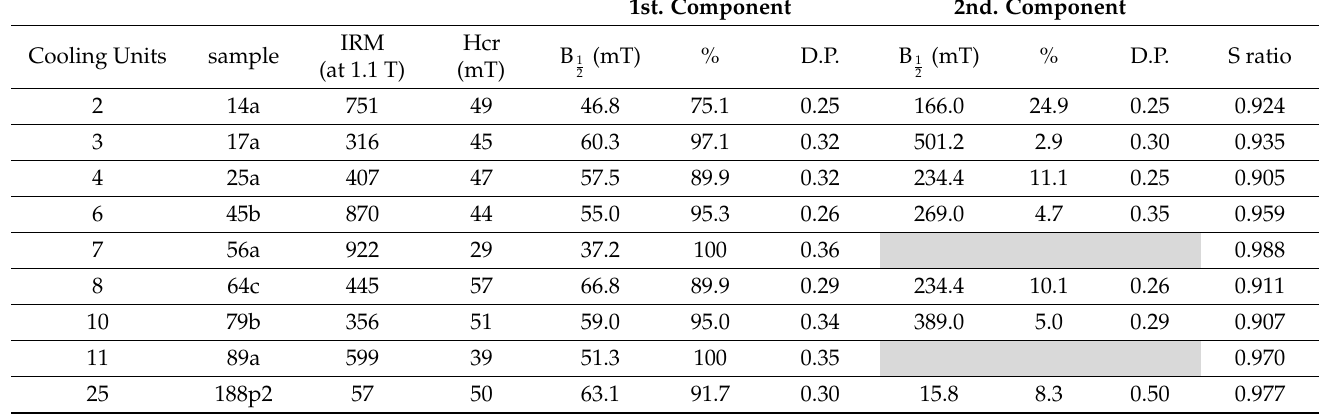
Table 1. Results of high field magnetic measurements. From left to write: Cooling Unit—number of unit; sample: sample reference; IRM—isothermal remanent magnetization at 1.1 T (in these samples virtually corresponds to the saturation isothermal remanent magnetization, SIRM); Hcr—Coercivity of remanence obtained from the back field application until the removal of magnetization; B 1/2 —the field at which half of the SIRM is reached; %—relative contribution of the component; DP—dispersion parameter, that reflects the dispersion of the coercivities within the modelled magnetic phase; S ratio: calculated from the IRM (0.3 T) /IRM (1 T)